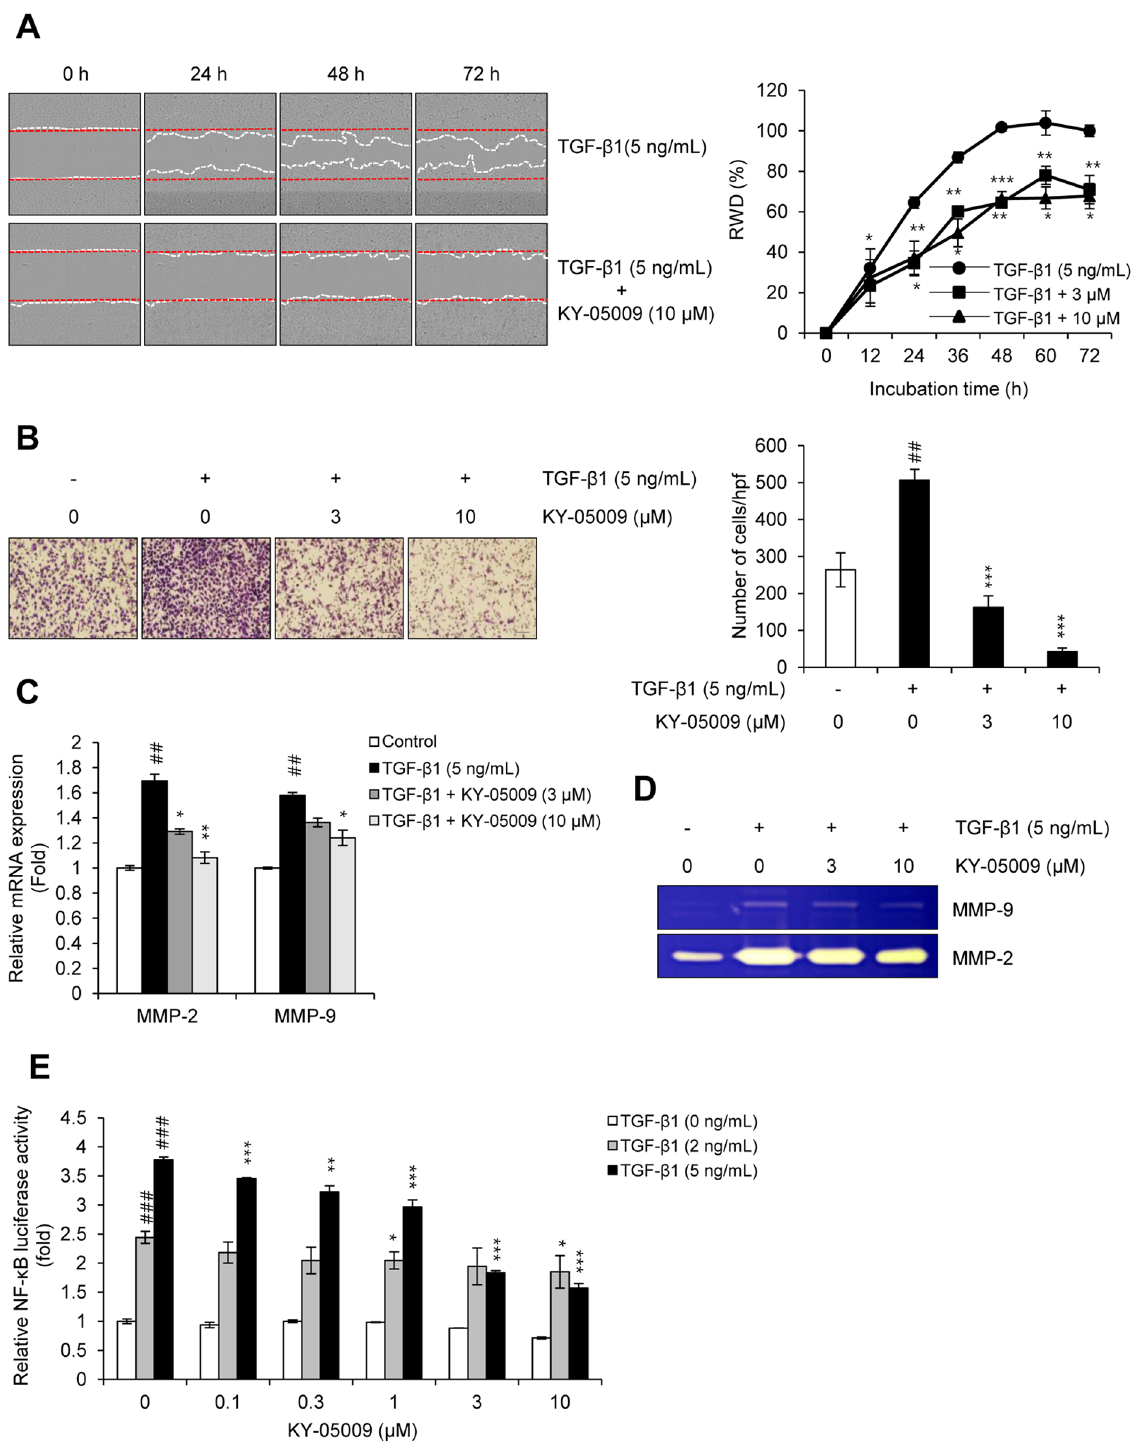
Figure 5. KY-05009 inhibits TGF- b 1-induced migration and invasion. The effect of KY-05009 on TGF- b 1-induced migration and invasion of A549 cells was evaluated using (A) IncuCyte software and (B) Boyden chambers, respectively. The red and white dashed lines a represent the wounded area and the edge of migrated cells, respectively. Values (% RWD; Relative Wound Density) represent mean 6 SD of triplicate samples, and reported images are representatives of triplicate experiments. Numbers of invaded cells were represented by an average number of cells per randomly selected three high-power field (HPF). Effects of KY-05009 on TGF- b 1-induced expression and activation of MMP-2 and MMP-9 were measured by (C) quantitative RT-PCR and (D) gelatin zymography, respectively. (E) The effect of KY-05009 on NF- k B transcriptional activity was determined by reporter assay. ## p , 0.01, ### p , 0.001 (versus ‘the control’); * p , 0.05, ** p , 0.01, *** p , 0.001 (versus ‘the group treated with TGF- b 1 only’).